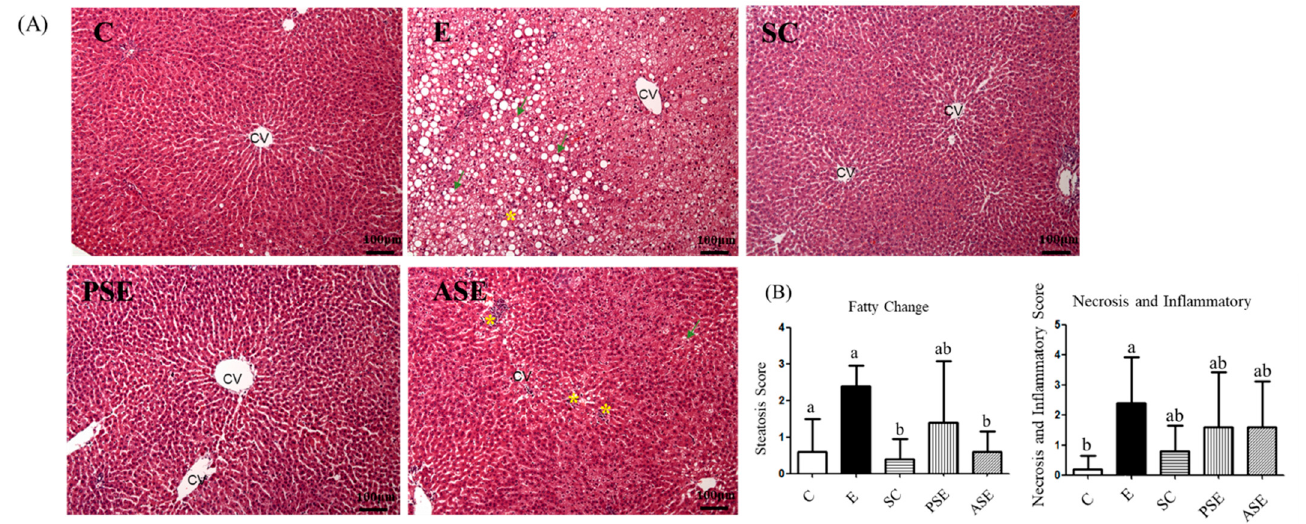
Figure 1. Effects of synbiotics on the histological examination of liver in rats with chronic ethanol feeding. ( A ) hematoxylin and eosin (H&E) staining of liver pathological changes. ( B ) Quantification of fatty changes and inflammatory cells. Data are expressed as the mean ± standard deviation ( n = 5). Different letters (a and b) indicate a significant difference at p < 0.05 by a one-way ANOVA with Duncan’s post-hoc test. Arrows indicate fatty droplets, while * indicates inflammatory cell in-filtration. CV, central vein.